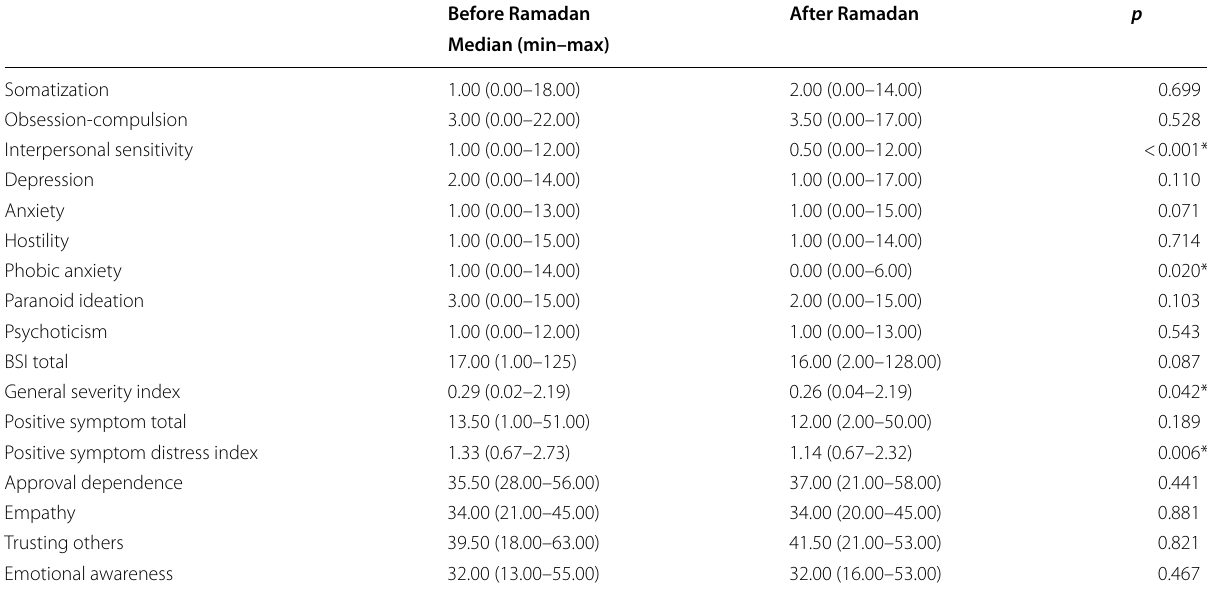
Table 2 Participants’ BSI and SDIR scores